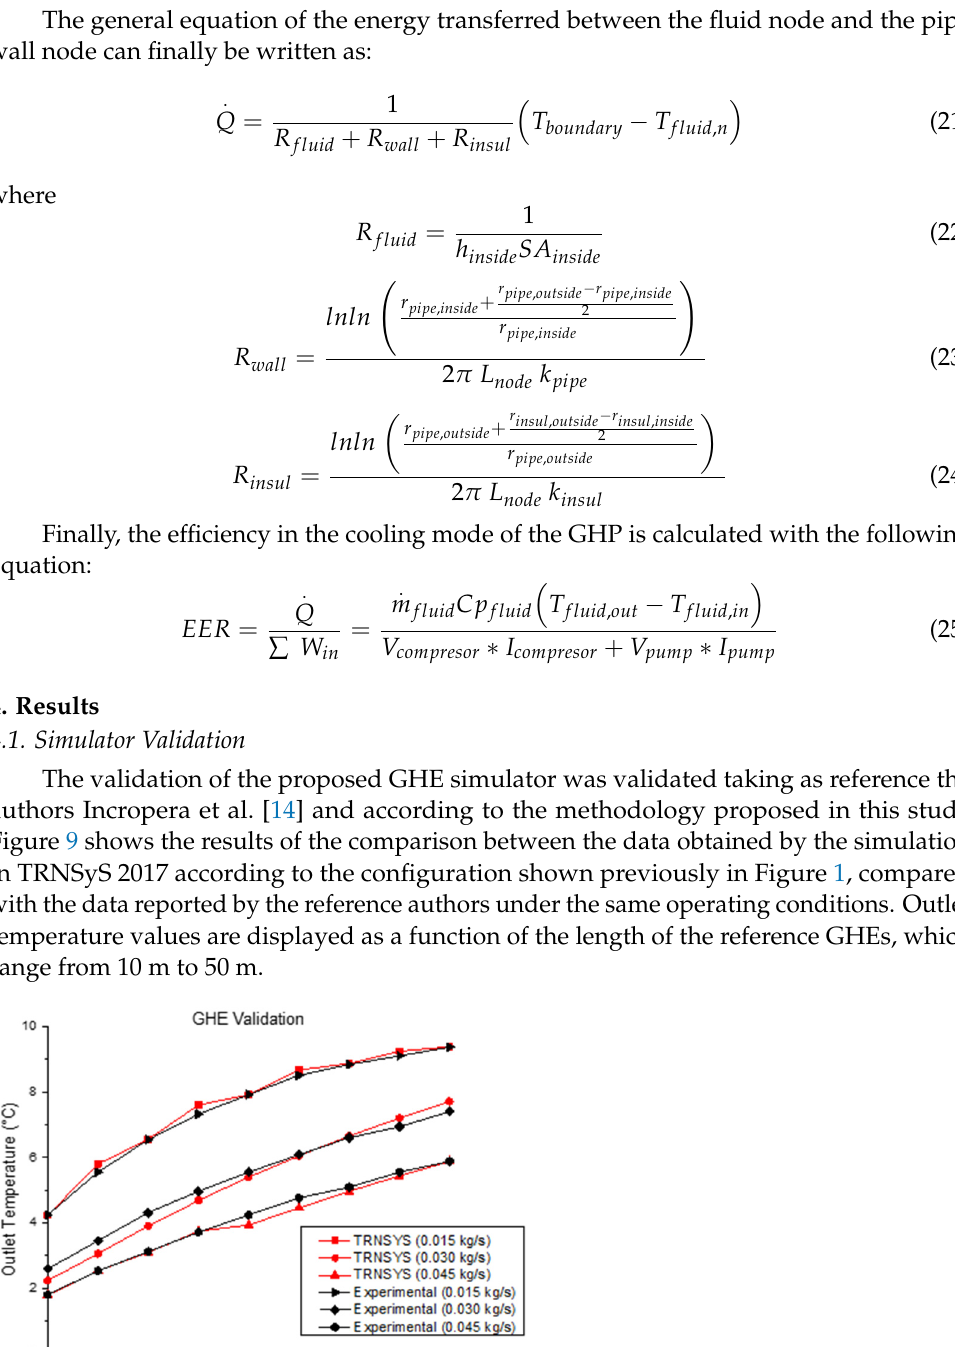
Table 2. The temperature of the fluid at different depths was used in the validation of the GHP simulator results.